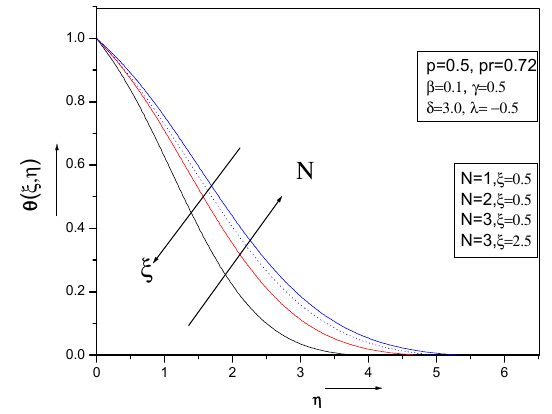
Figure 4. Effect of the magnetic force parameter on magnetic field profile.